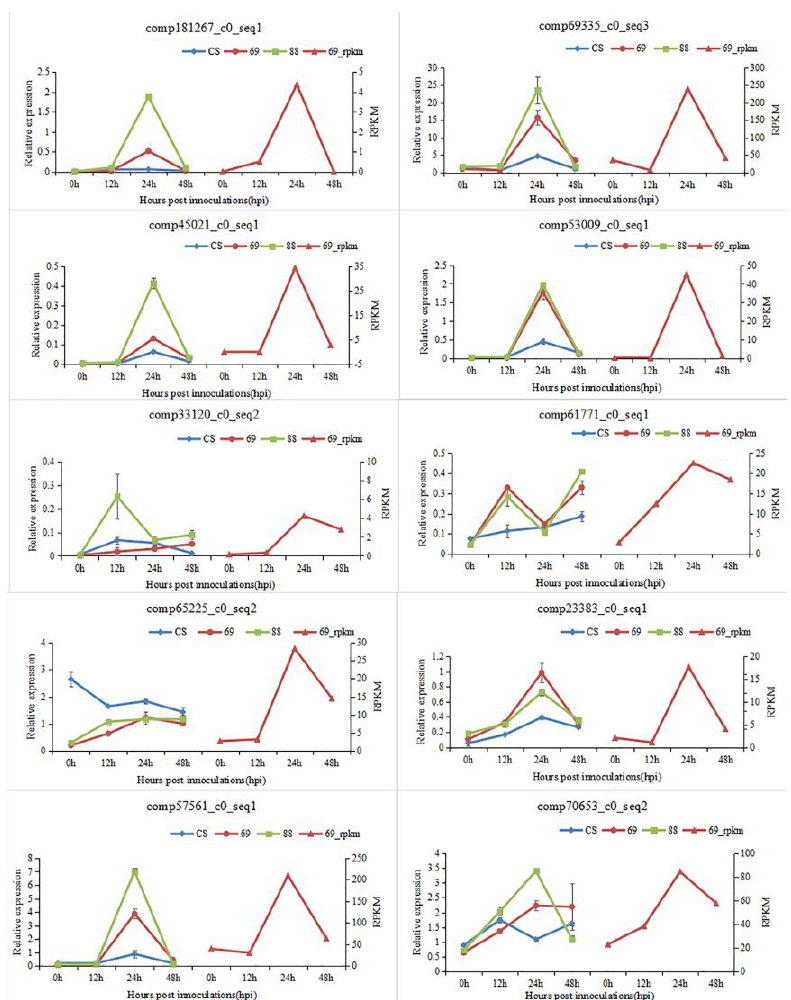
Figure 1. Validation of RNA sequencing results by qRT-PCR. Gene expression displaying on the left side of each graph resulted from qRT-PCR using specific primer pairs listed in Supplementary Table S3; gene expression of line 89-69 (in red color) on the right side of each graph was based on analysis of RNA sequencing data in each photo.